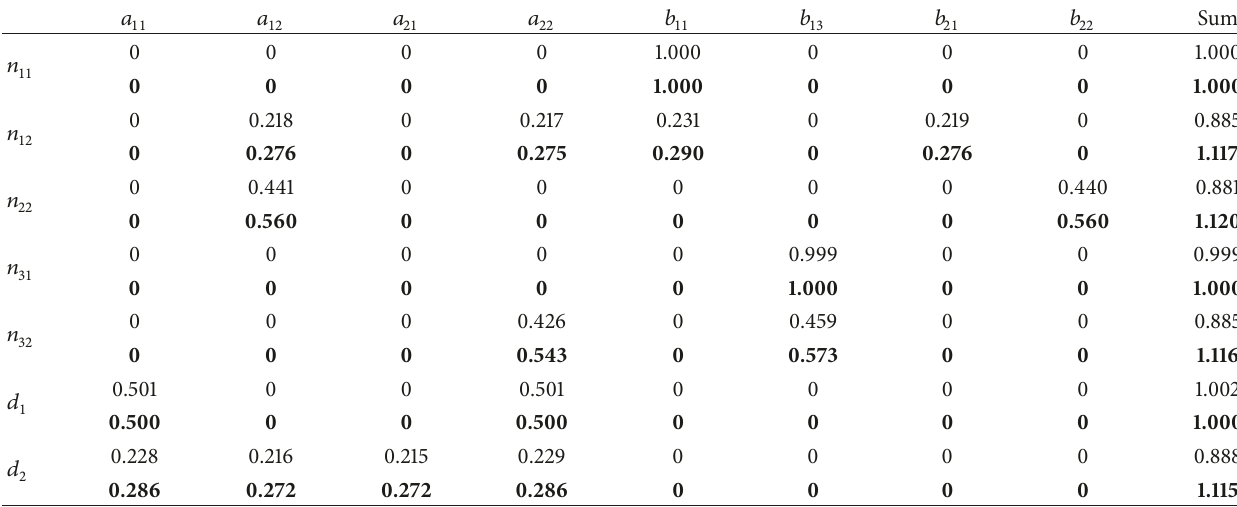
Table 8: First-order and total sensitivity indices, SS to ARX